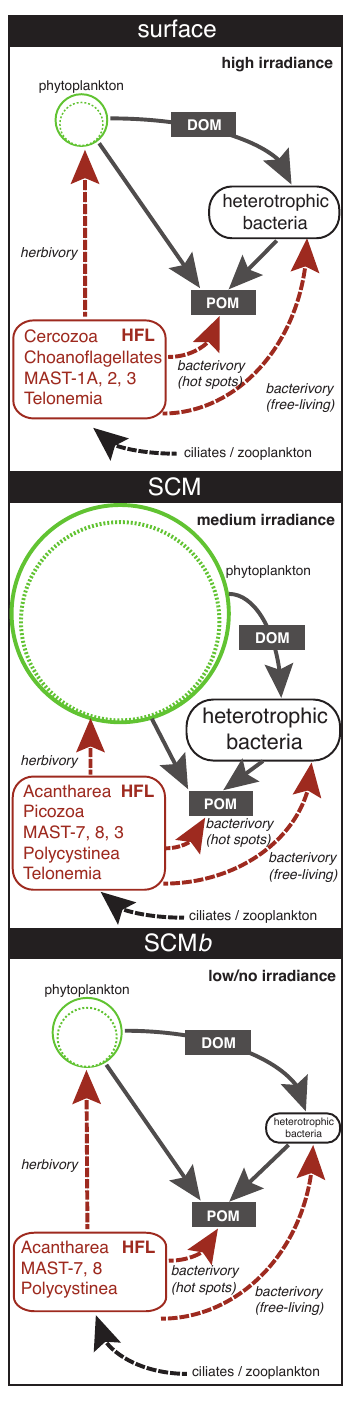
Fig. 6. Schematic of the trophic networks in the upper Arctic Ocean, in light of HFL taxonomic information within the upper water col- umn: surface, SCM and SCM b . Bacteria counts and phytoplankton (chl a ) are scaled to actual values available at http://malina.obs-vlfr. fr. For phytoplankton, inner and outer circles represent small and total fractions from extracted chl a values,